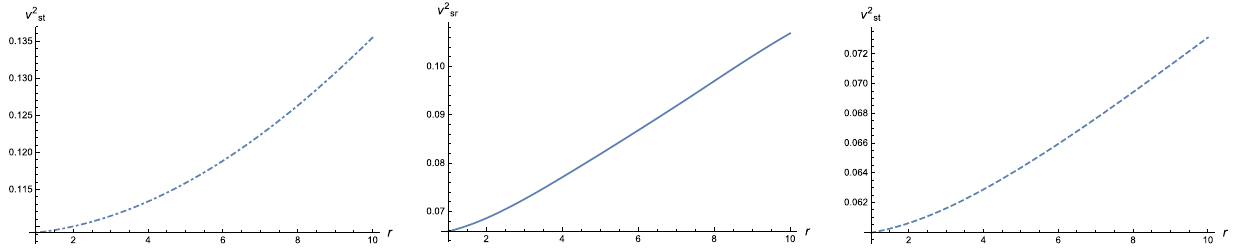
Fig. 8 Variations of v 2 sr with respect radius r (km) of the strange star candidate Her X-1, SAX J 1808.4-3658, and 4U 1820-30; represented by (left to right) the first, second, and third graphs, respectively